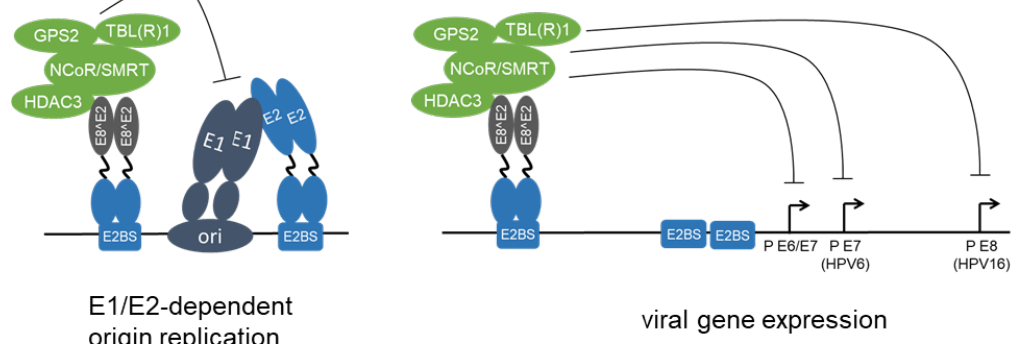
Figure 3. HPV E8ˆE2 proteins repress viral replication and transcription. HPV E8ˆE2 proteins bind to E2BS via the DNA binding domain within the C-terminal part shared by full-length E2 and E8ˆE2. The E8 domain recruits NCoR/SMRT corepressor complexes composed of GPS2, HDAC3, NCoR, SMRT, TBL1, and TBLR1, and this inhibits both E1/E2-dependent replication of the viral origin and the transcription from different viral promoters.